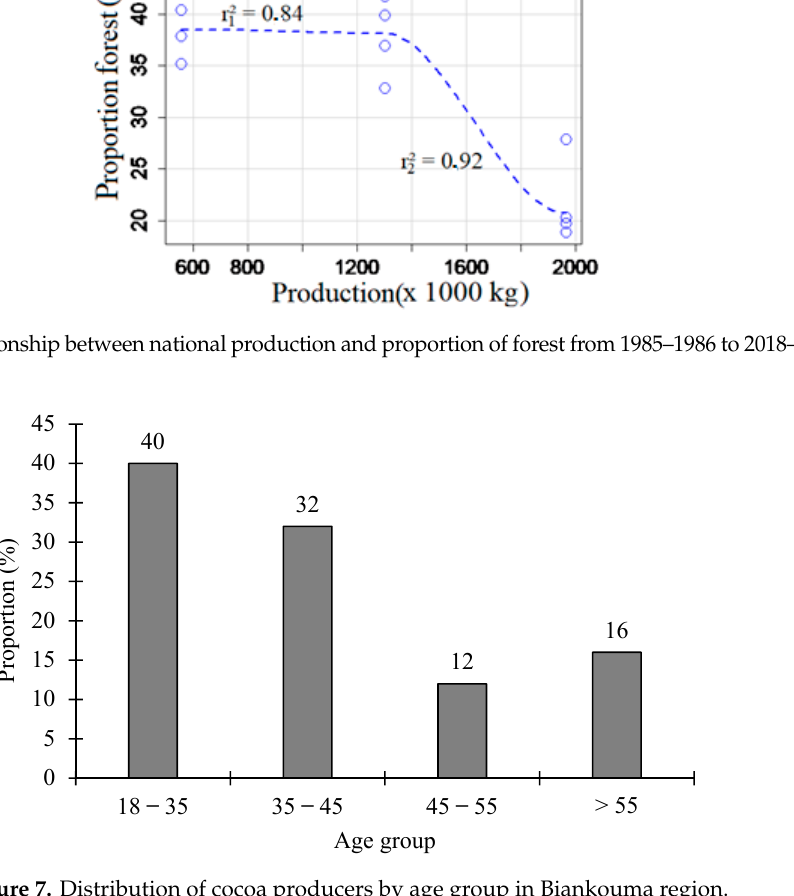
Figure 7. Distribution of cocoa producers by age group in Biankouma region.